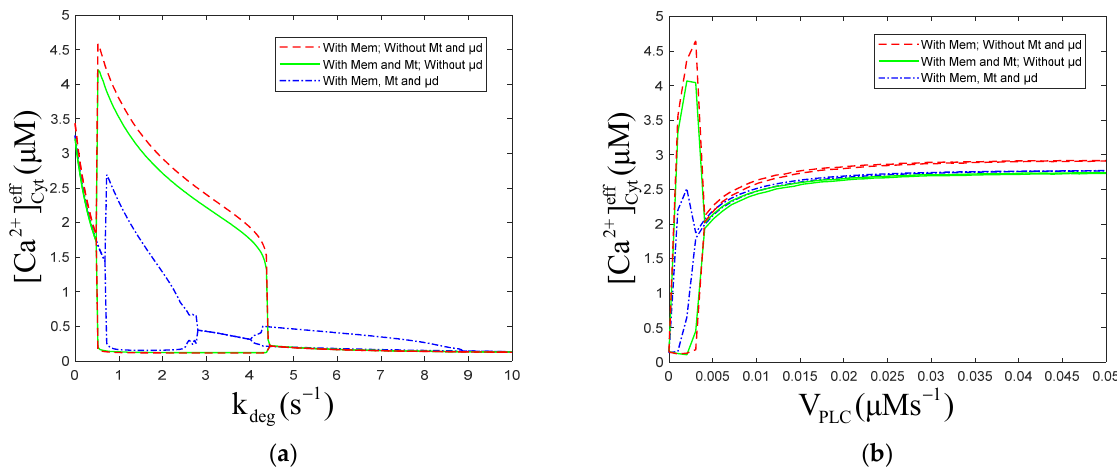
( a ) ( b ) eff 2+ [Ca ] 2+ eff Figure 2. Numerical oscillation analysis diagrams of the [ Ca 2 + ] of effective cytosolic compartment ( [ Ca 2 + ] ) according to [Ca ] ) according Cyt Figure 2. Numerical oscillation analysis diagrams of the of effective cytosolic compartment ( Cyt ( a ) k deg and ( b ) V PLC . K PLC = 0.12 µ M, K deg = 0.1 µ M, D = 40 nm, and ( a ) V PLC = 1 µ M s − 1 , ( b ) k deg = 0.1 s − 1 . Stimulation 1 k V = 0.12 μM K = 0.1 μM K = 1 μM s V − = 0.1 s k − applied at 50 s. The other parameters and constants are taken from Table 1. V PLC is the maximal production rate of and ( b ) . , ( b ) . to ( a ) deg PLC deg PLC deg PLC PLC isoforms, K PLC is the sensitivity of PLC to Ca 2 + , k deg represents the phosphorylation rate constants, K deg is the V half-saturation constant of IP 3 kinases. ( a ) With Mem, without Mt and µ d, the oscillation range of k deg is 0.48 to 4.45 s − 1 . Stimulation applied at 50 s. The other parameters and constants are taken from Table 1. is the maximal production PLC With Mem and Mt, without µ d, the oscillation range of k deg is 0.48 to 4.45 s − 1 . With Mem, Mt and µ d, the oscillation range of k K K is the sensitivity of PLC to 2+ C a , deg represents the phosphorylation rate constants, is rate of PLC isoforms, k deg is 0.64 to 2.85 s − 1 and 4.01 to 8.93 s − 1 . ( b ) With Mem, without Mt and µ d, the oscillation range of V PLC is 0 to 0.004 s − 1 . deg PLC With Mem and Mt, without µ d, the oscillation range of V PLC is 0 to 0.004 s − 1 .With Mem, Mt and µ d, the oscillation range of k IP kinases. ( a ) With Mem, without Mt and μ d, the oscillation range of deg is 0.48 to 4.45 the half-saturation constant of V PLC is 0 to 0.003 µ M s − 1 . From ( a , b ), Mem, Mt and µ d all can inhibit the amplitude of calcium oscillations, but only µ d can 3 reduce oscillation